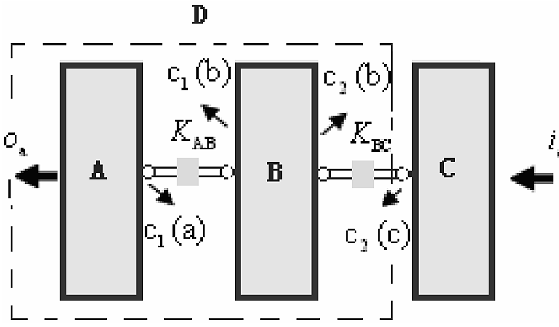
Fig. 8. One-coordinate coupled three-substructure system.